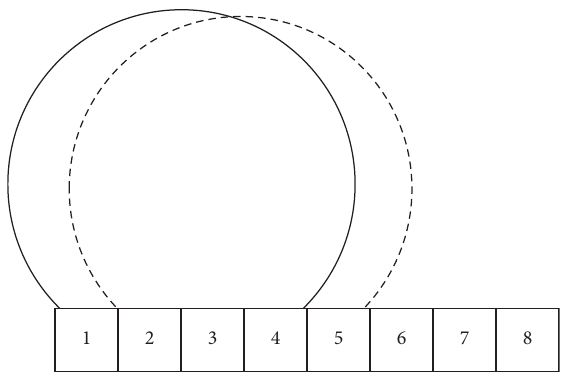
Figure 6: Loading step of moving